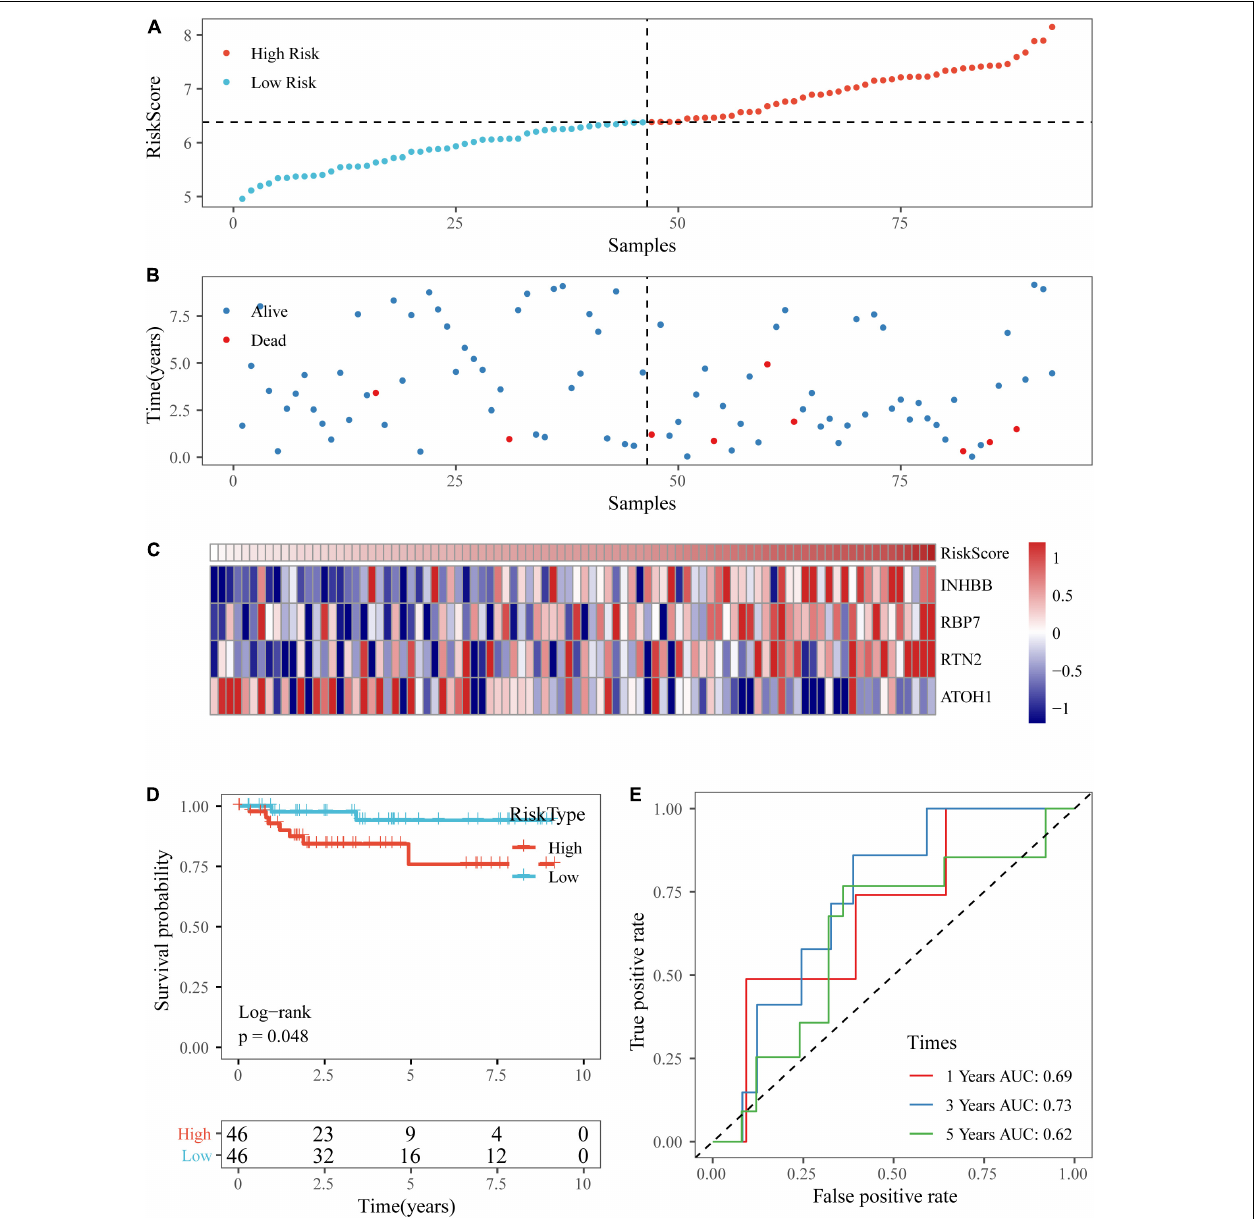
FIGURE 10 | Verification of the four-gene signature in the GSE38832 dataset. (A,B) The distribution of risk scores in the GSE38832 dataset and the distribution of corresponding survival states. (C) Heatmaps of gene expression in the risk score model. (D,E) KM curves and ROC curves of the risk score in the GSE38832